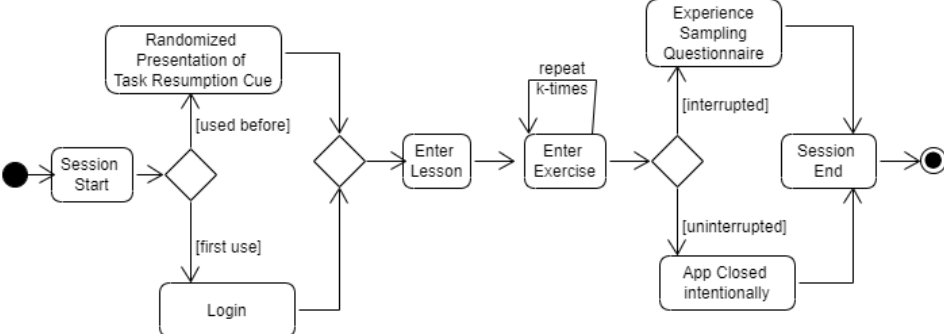
Figure 9. A visualization of the app functionality revised for the field study. After entering the app, the user is presented with a randomized cue before starting a lesson and the respective